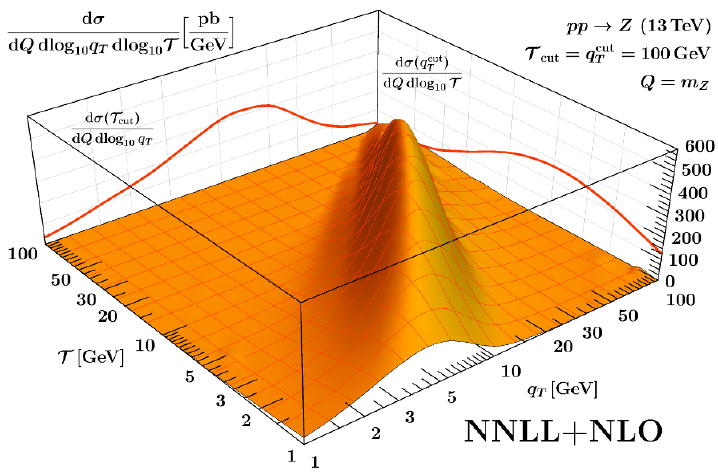
Figure 1 . The Drell-Yan cross section double-di(cid:11)erential in the transverse momentum q T of the Z boson and the 0-jettiness event shape T at NNLL+NLO. For better visibility, the spectrum is plotted with respect to log q T and log T . On the two side walls we show the corresponding 10 10 single-di(cid:11)erential spectra in q T and T obtained by integrating the double-di(cid:11)erential spectrum up to T cut = 100 GeV and q cut = 100 GeV, T